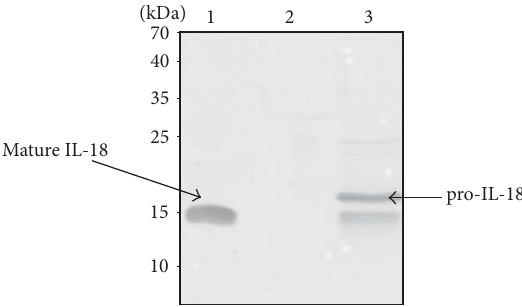
Figure 2: Immunoblot analysis of rBCGhIL-18. Lane 1 contains 100ng of mature IL-18 . Whole-cell extracts of nonrecombinant BCG (lane 2) or rBCGhIL-18 (lane 3), each corresponding to an optical density at 600 nm of 0.2 were subjected to SDS-PAGE and analyzed by immunoblotting using rabbit anti-IL-18 antibodies. The sizes of the molecular weight markers are indicated in the left margin, and the presence of mature IL-18 and pro-IL-18 is indicated by